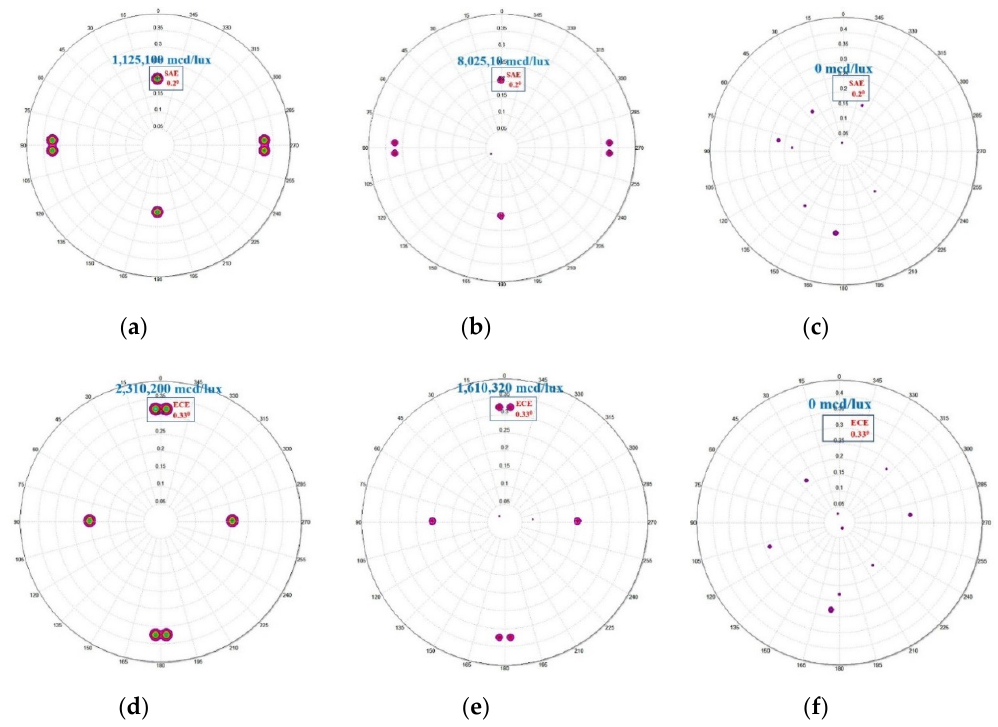
Figure 10. The R I and intensity distributions on anterior, central, and posterior regions, which are shown in: ( a – c ) SAE SuperPin Plus curved; ( d – f ) ECE SuperPin Plus curved.